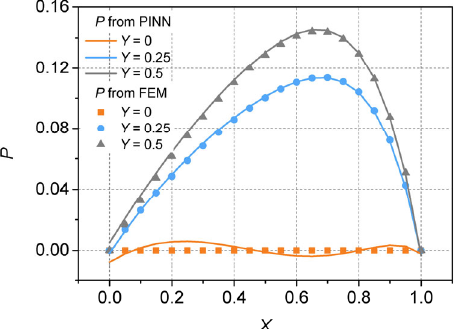
Fig. 6 Comparison of the pressure obtained by PINN and FEM ( N e =